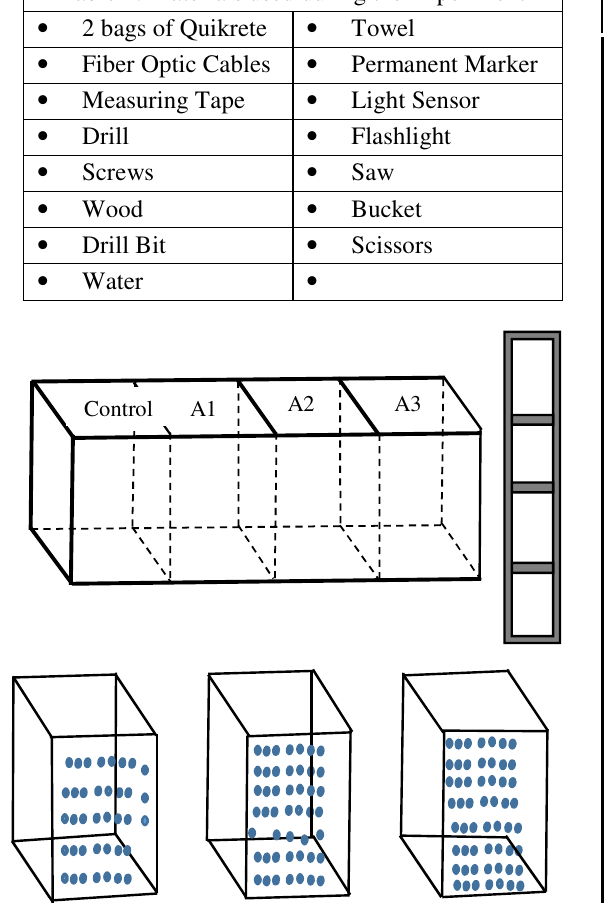
Fig. 3: Capstone Notes- Illustration of Mold